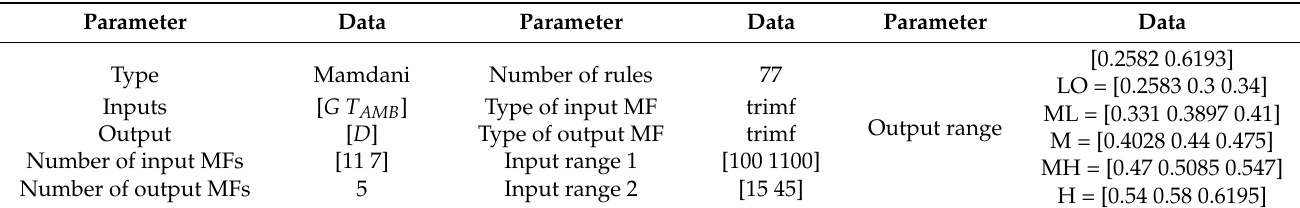
Table 5. Parameters of the fuzzy controller with the input variables G and T AMB.